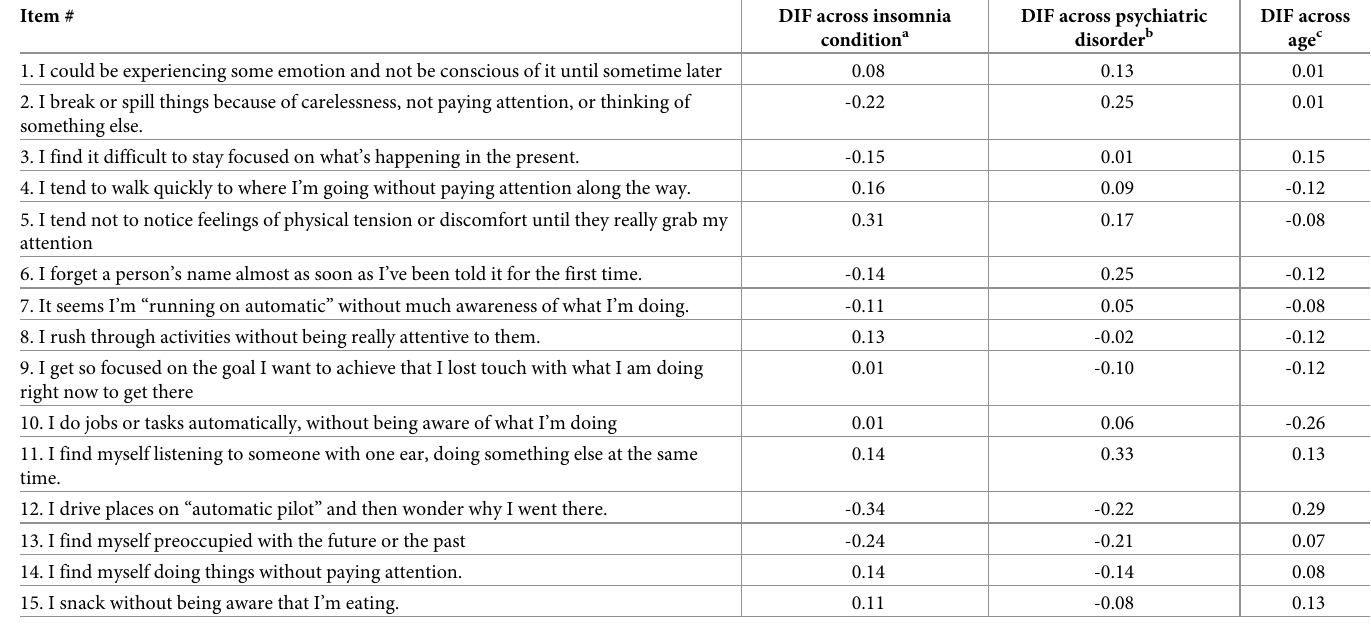
Table 5. Differential item functioning (DIF) across different subgroups in the Mindful Attention Awareness